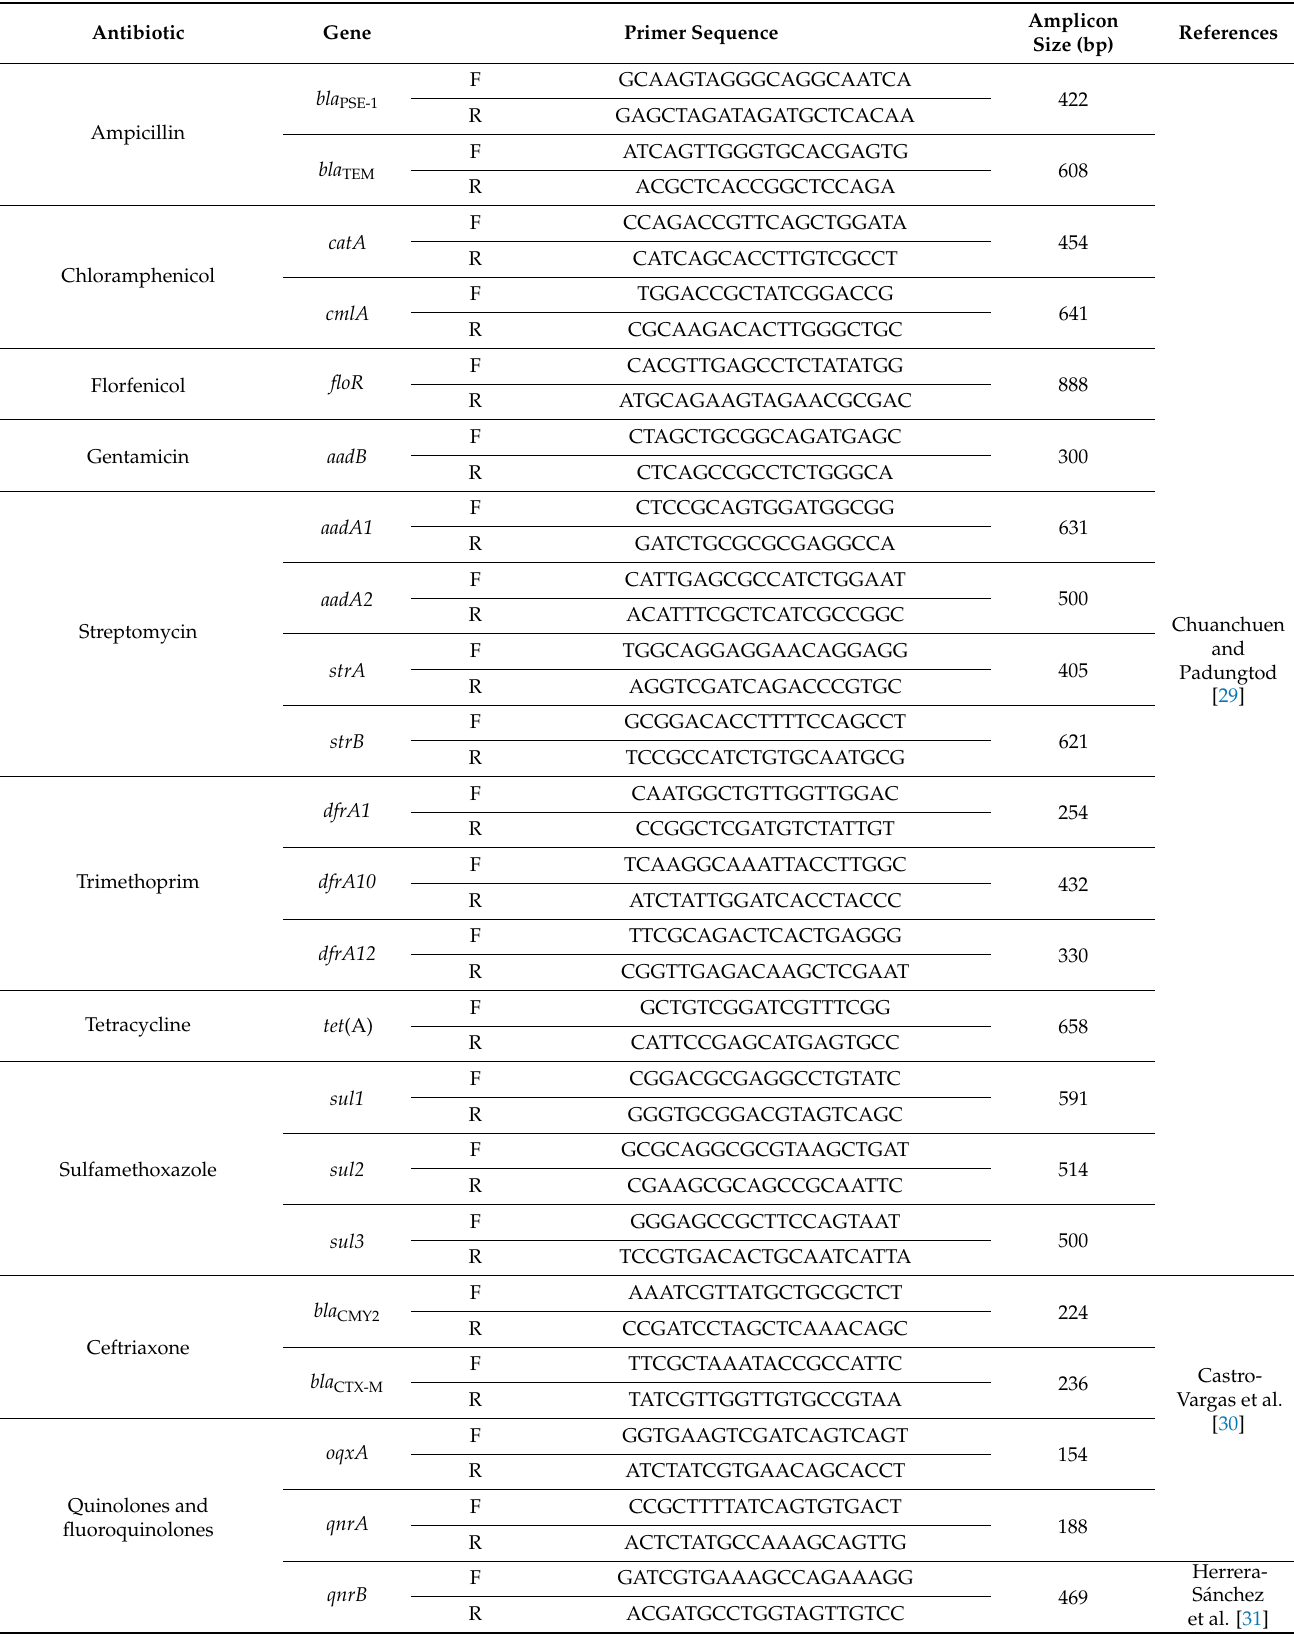
Table 2. Primer sequences used for amplification of resistance genes in Salmonella spp.